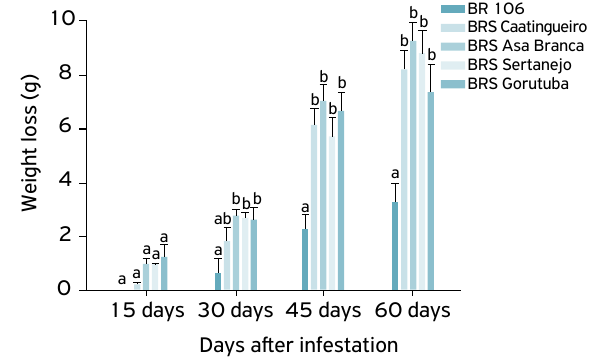
Figure 1. Weight loss of different maize cultivars submitted to Sitophilus zeamais